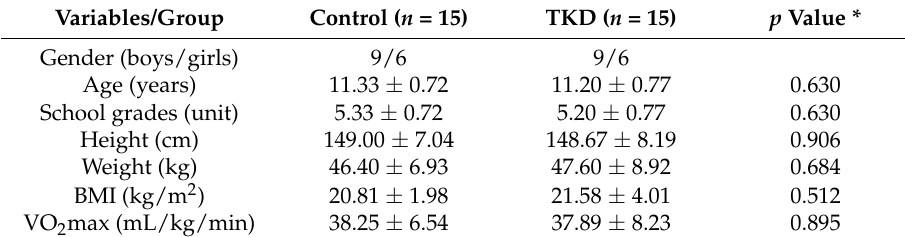
Table 1. Physical characteristics of the subjects at baseline.